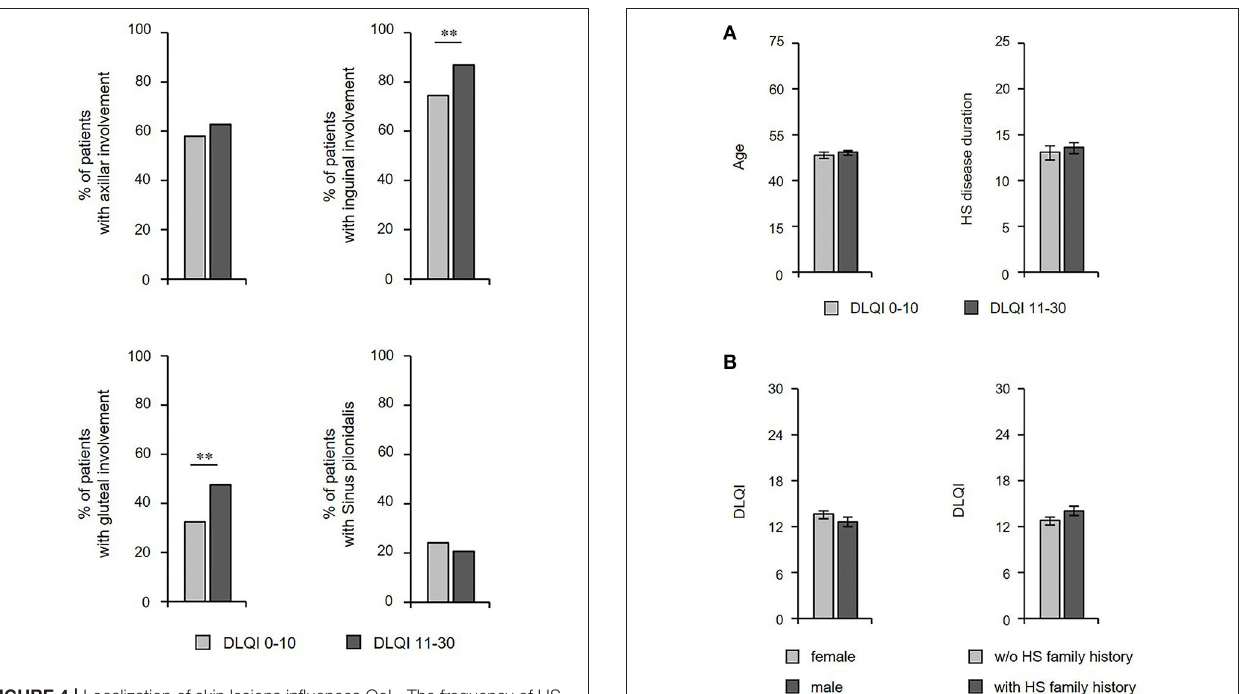
FIGURE 5 | The QoL impairment is not related to the age, disease duration, and family history of HS patients. (A) The age ( n = 462) and HS disease duration ( n = 440) in HS patients with small/moderate (DLQI ≤ 10) vs. very/extremely large (DLQI > 10) QoL impairment is given as mean ± SEM. (B) DLQI scores among female and male HS patients (left panel; n = 462) as well as patients with or without a HS family history (right panel; n = 459) are given as mean ± SEM. DLQI, Dermatology Life Quality